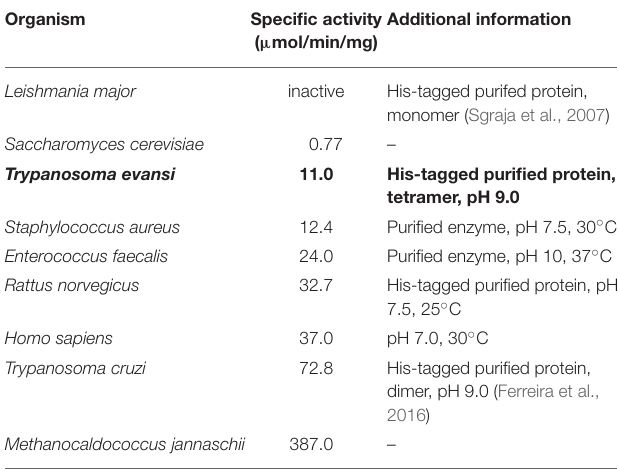
TABLE 1 | Enzymatic activity of specific